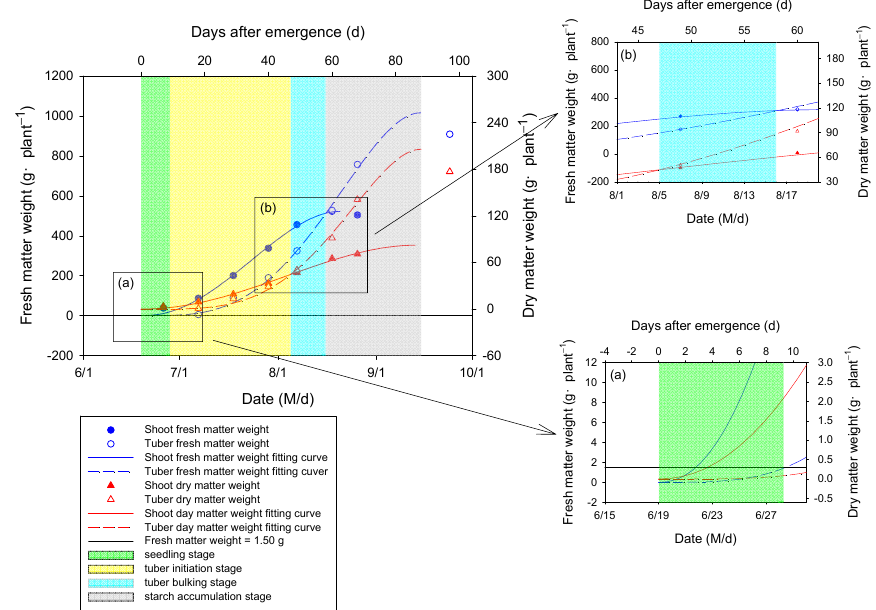
Figure 2. Growth stages determination method. ( a ) The magni fi cation of box a, indicating the beginning of the tuber initiation stage; ( b ) The magni fi cation of box b, indicating the beginning of the tuber bulking stage and the Starch accumulation stage, respectively.